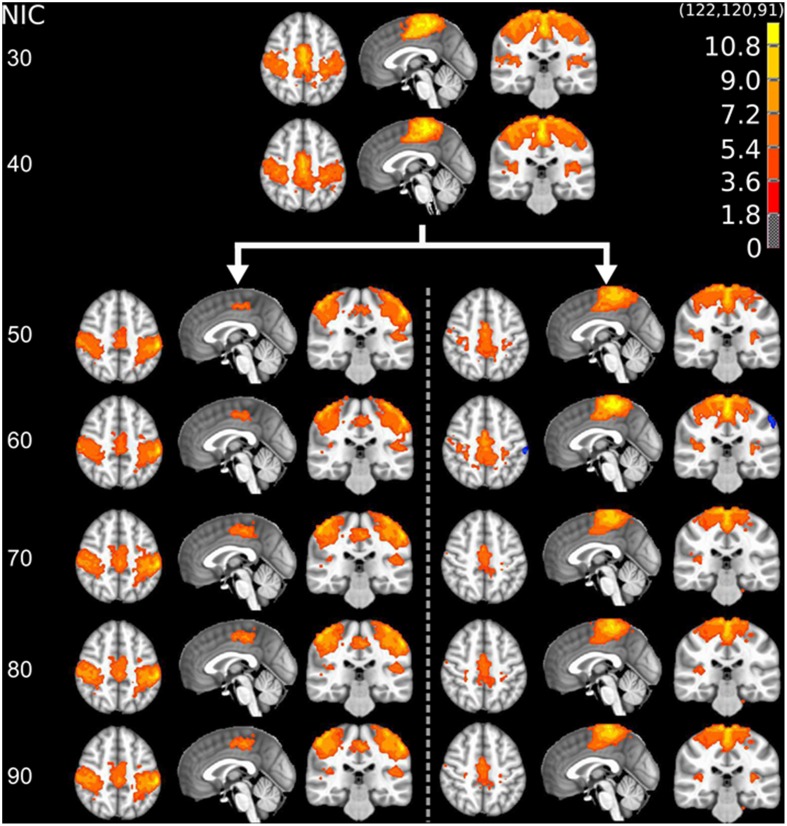
The tracking results of dataset 1 for a typical RFN through similarity matching. The motor-sensory functional network was tracked at NIC = 20–100. The IC splits into two potential RFNs with high similarity to the original IC, when NIC = 50.